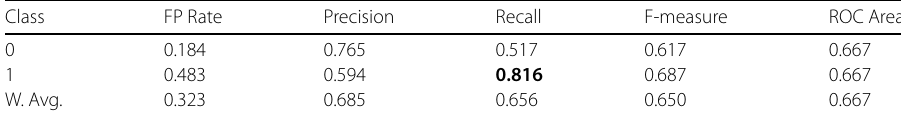
Table 6 Testing accuracy per class for the region of interest detection task. Low precision indicates that the problem is hard to solve using classification at fine level granularity. However, a simple 0/1 classifier is sufficient to infer the region of interest with 0.816 recall Class FP Rate Precision Recall F-measure ROC Area